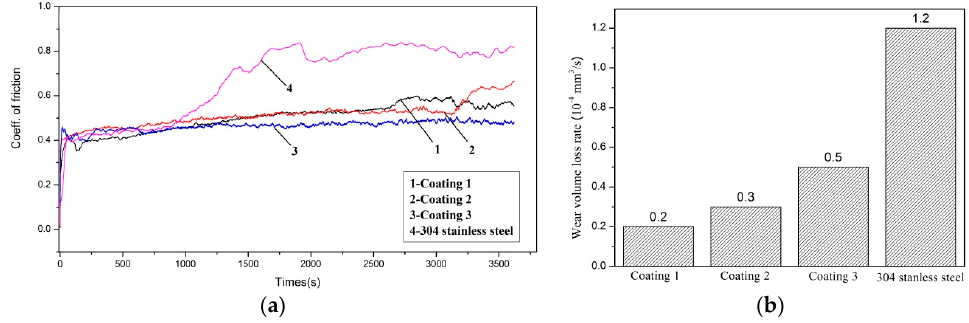
Figure 13. ( a ) Friction coefficient and ( b ) wear volume loss rates of laser cladding Ni-Cr-Si coatings and the reference materials 304 stainless steel.